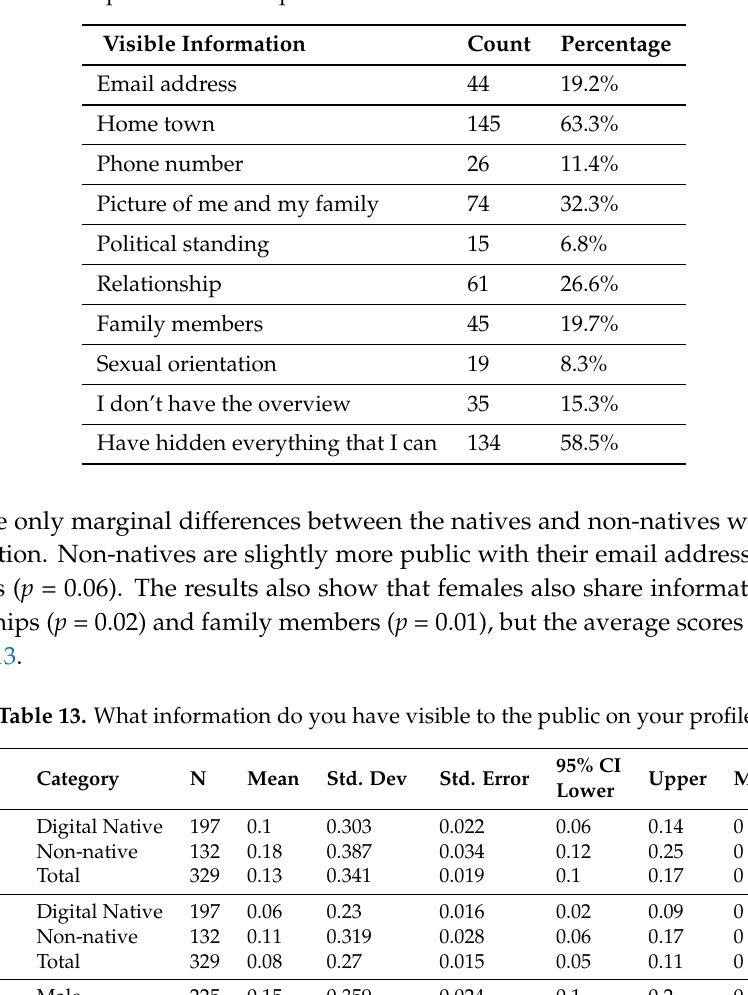
Table 12. Shows how many people have what kind of information visible and the percentage based on the number of total respondents on the questionnaire 329.